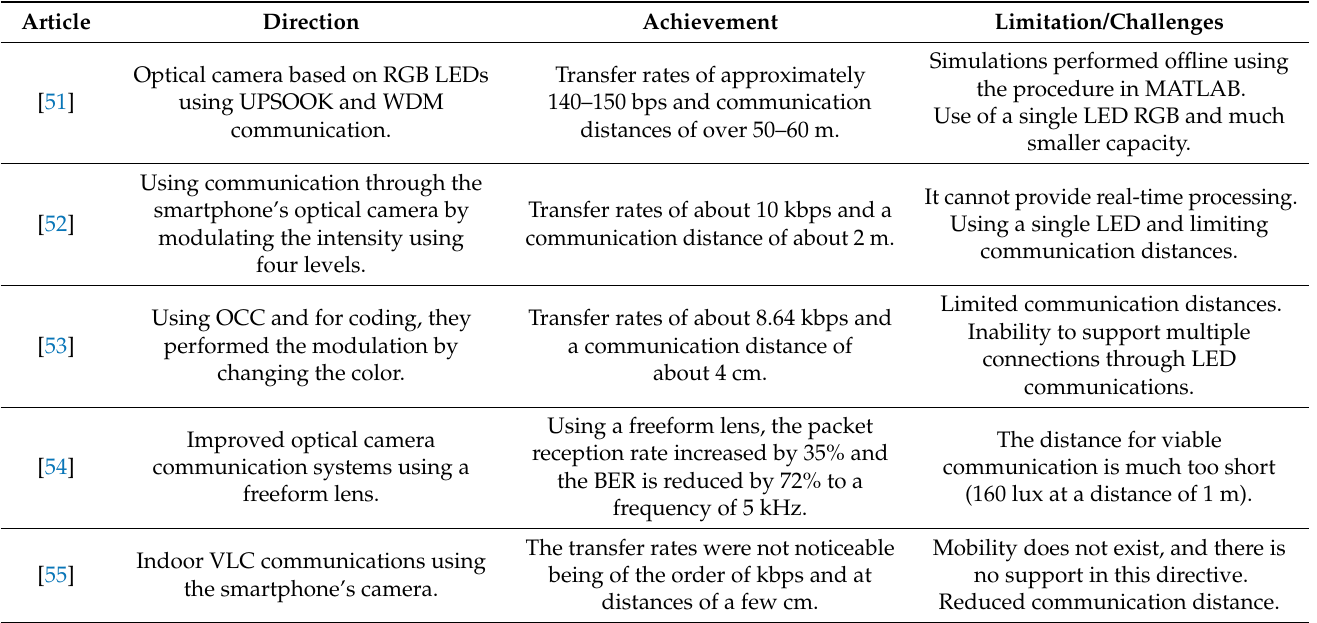
Table 1. Studies and implementations regarding OCC communications, limitations, challenges and results